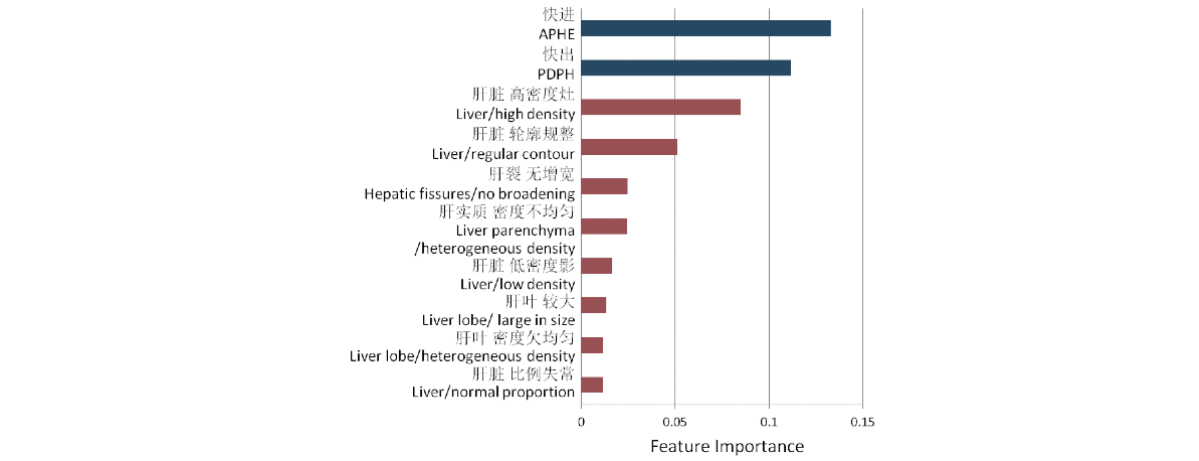
Figure 3. Top 10 radiological features linked with liver cancer diagnosis ranked by feature importance score. APHE: hyperintense enhancement in the arterial phase; PDPH: hypointense in the portal and delayed